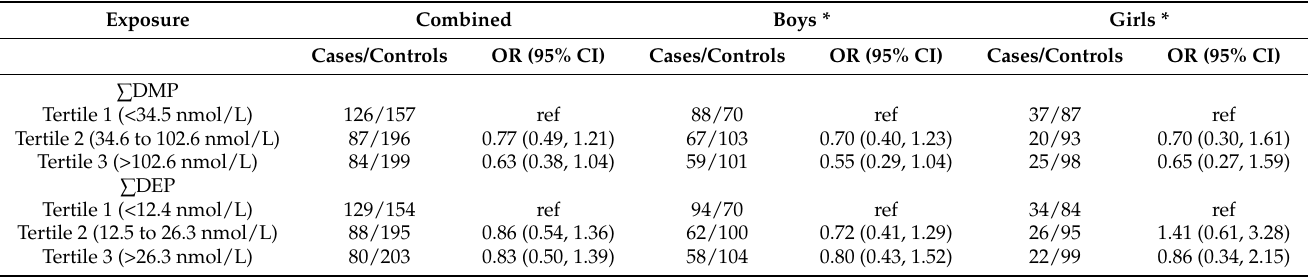
Table 3. Estimated overall and sex-specific odds of having a child with attention-deficit/hyperactivity disorder (ADHD) per tertile of organophosphorus pesticide metabolite concentration at 17 weeks’ gestation, adjusted for covariates, in a nested case-control study of ADHD in Norwegian Mother, Father, and Child Cohort Study, birth years